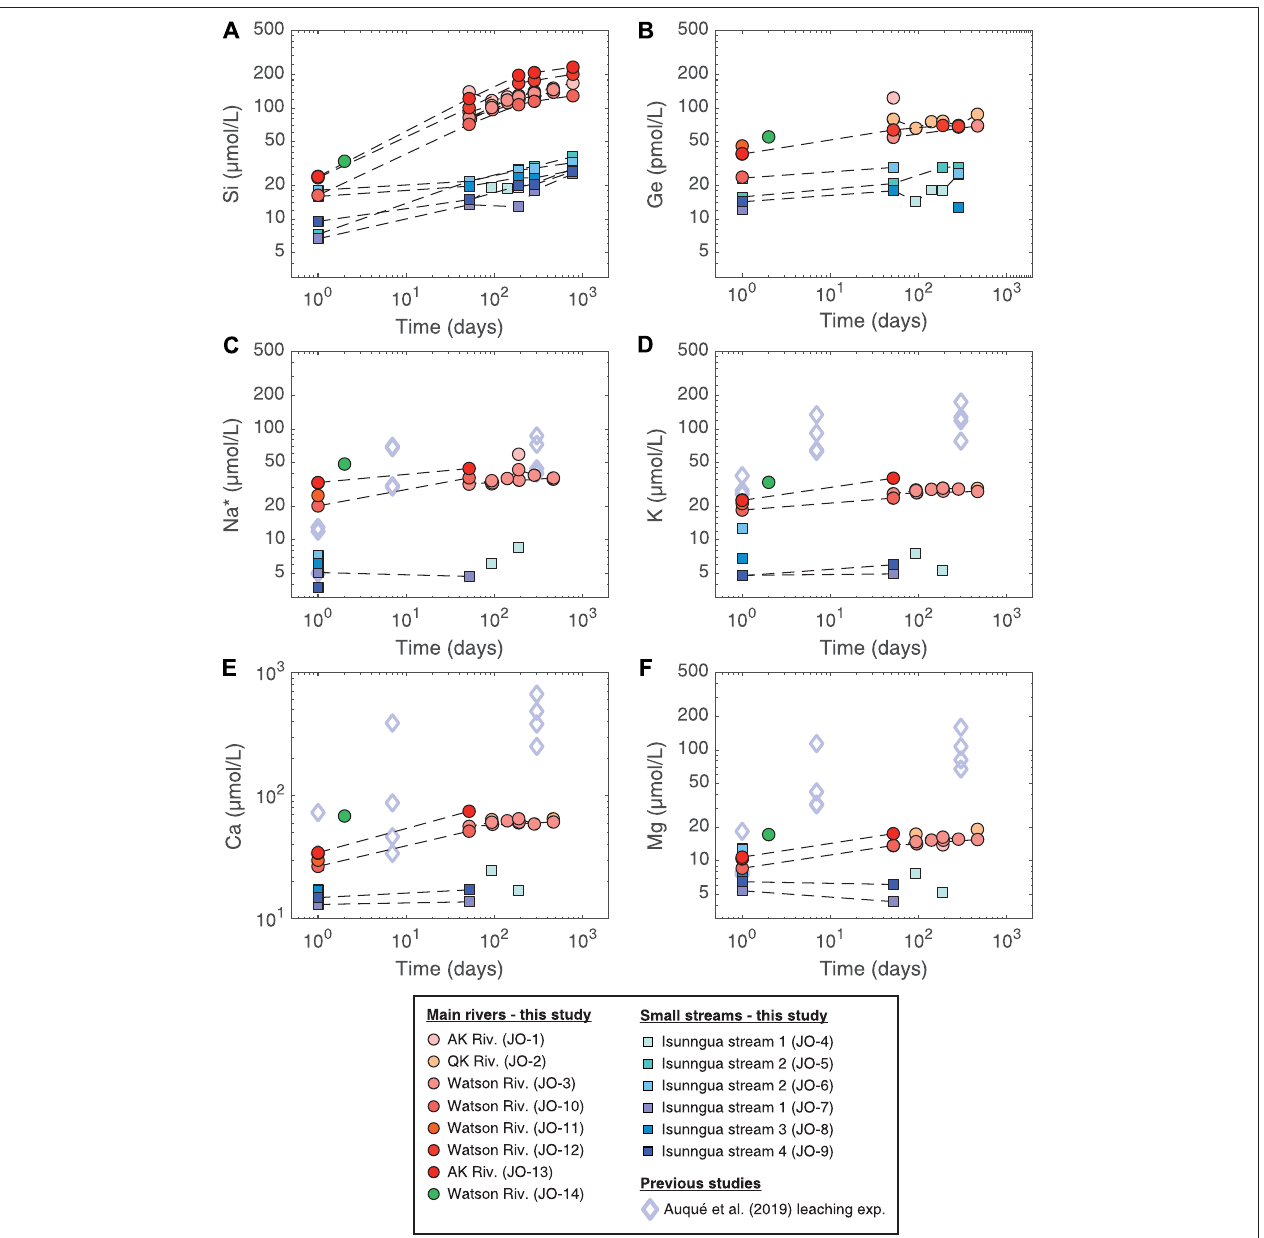
FIGURE 2 | Evolution of dissolved element concentrations during the course of the lab weathering experiment. Also shown are the results of Auqué et al. (2019), where Isunngua moraine till was leached using deionized water for up to 1 year but at a much higher sediment/water ratio equivalent to ∼ 600 g/L suspended sediment concentration. Na* refers to Na concentrations corrected for cyclic salt inputs (Na* (cid:1) Na – 0.85 · Cl), where Cl concentrations were assumed to be equal to 3 and 0.5 µmol/L for main river and Isunngua stream samples, respectively, based on literature data (Wimpenny et al., 2010; Hindshaw et al., 2014; Hatton et al., 2019a; Deuerling et al.,